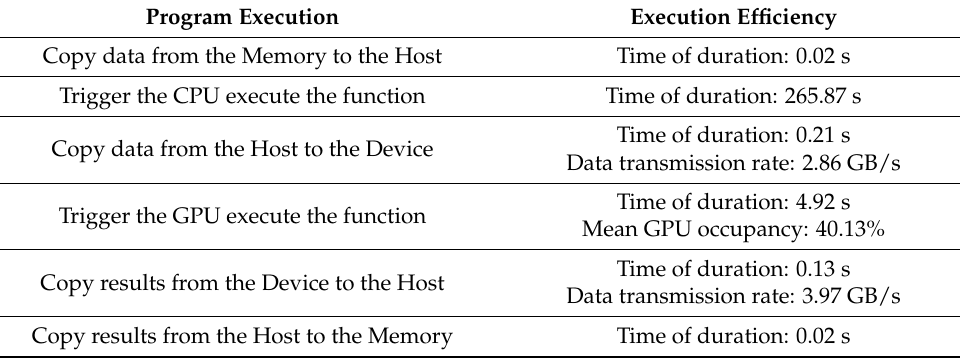
Table 7. Detailed analyses of the execution efficiency of GNKMNF with a data size of 64 × 64 ×